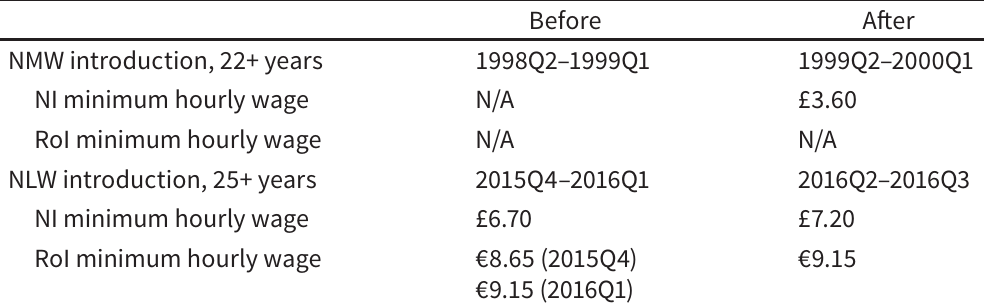
Introduction of NMW and NLW as natural experiments Before